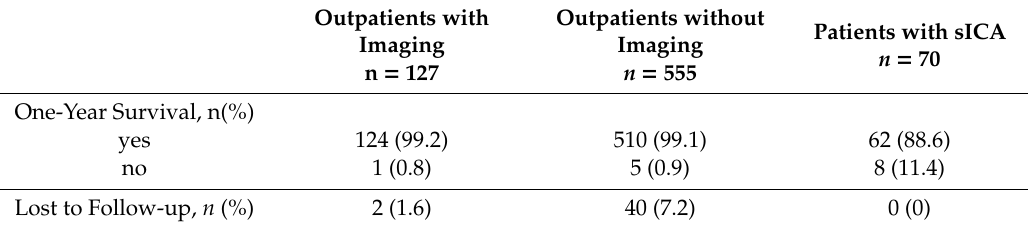
Table 5. One-year